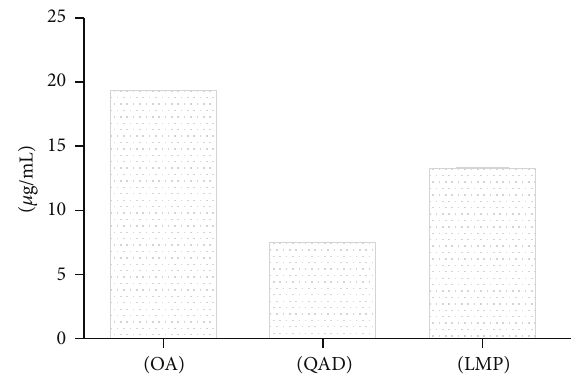
Figure 2: Concentrations of derivatives of oxindole alkaloids (OA), quinovic acid derivatives (QAD), and low molecular weight polyphenols present in the aqueous extract.